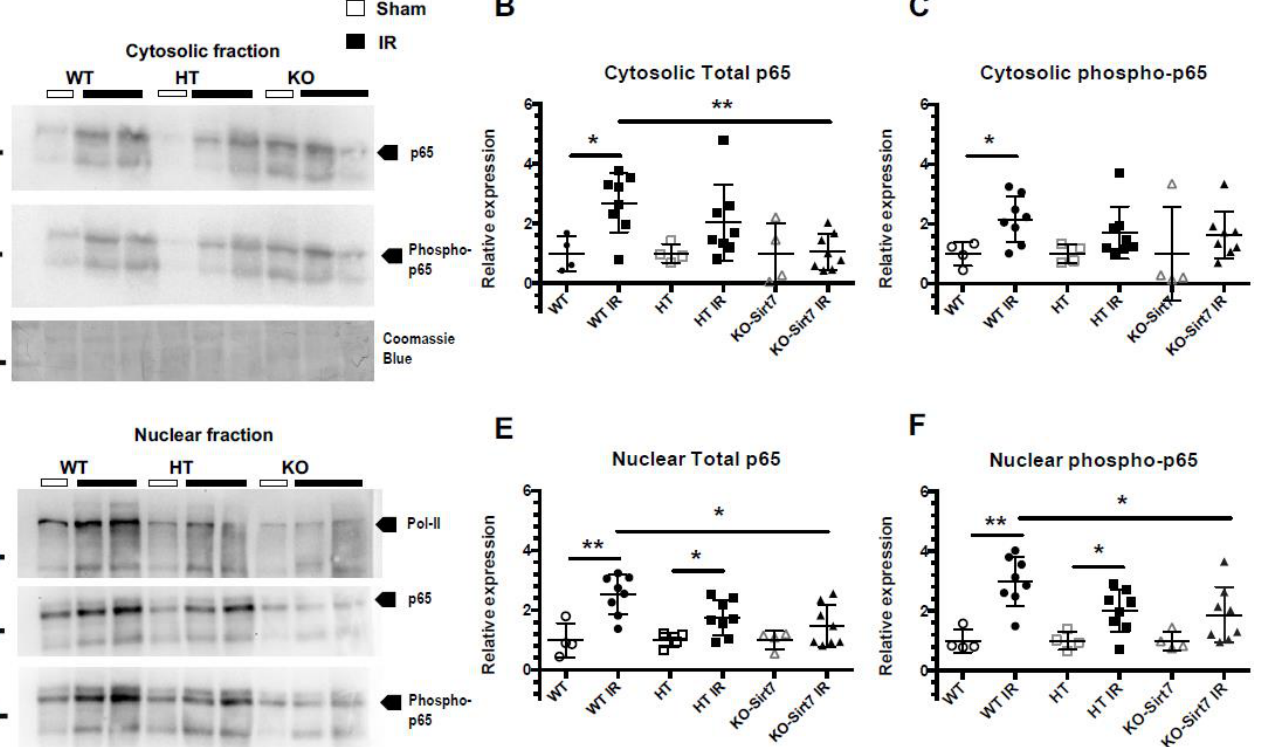
Figure 7. NFkB activation is modulated by SIRT7. ( A ) Protein levels of Total p65, phospho-p65 (Ser 536) and Coomassie Blue in cytosolic fractions. ( B , C ) Relative expression of p65 and phospho-p65 in cytosolic fractions based on densitometric analysis. ( D ) Protein levels of polymerase II (Pol II), Total p65, and phospho-p65 (Ser 536) in nuclear fractions. ( E , F ) Relative expression of p65 and phospho-p65 in nuclear fractions based on densitometric analysis. White circles represented WT, Black circles, WT+IR, White squares, HT-Sirt7, Black squares, HT-Sirt7+IR, White triangles, KO-Sirt7, and Black triangles, KO-Sirt7+IR. N = nuclei. C = Cytosol. n = 5 for control groups and n = 9 for experimental groups. * p <0.05 vs. as stated and ** p <0.01 vs. as stated